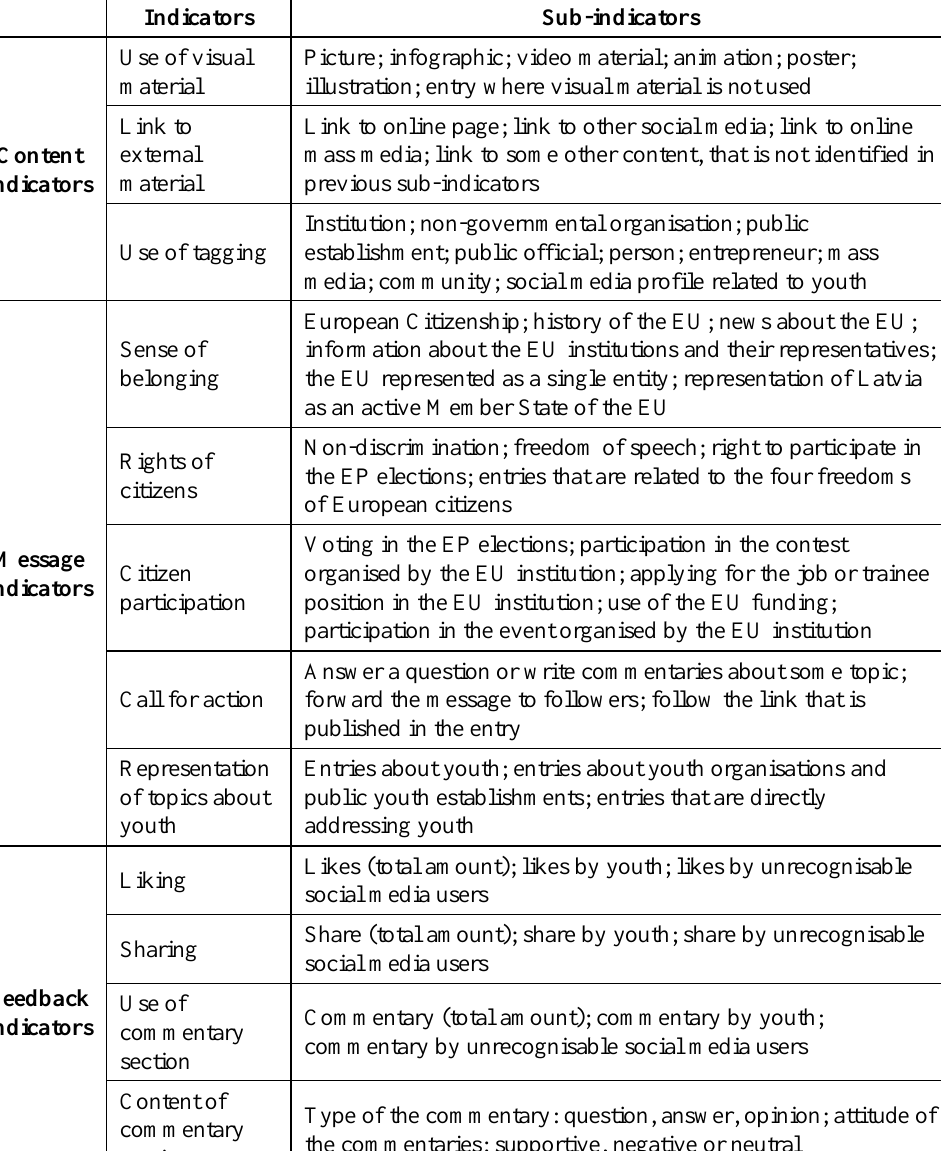
Table 1. Indicators and Sub-indicators Analysed in the European Parliament’s Social Media Entries from 1 July to 31 December